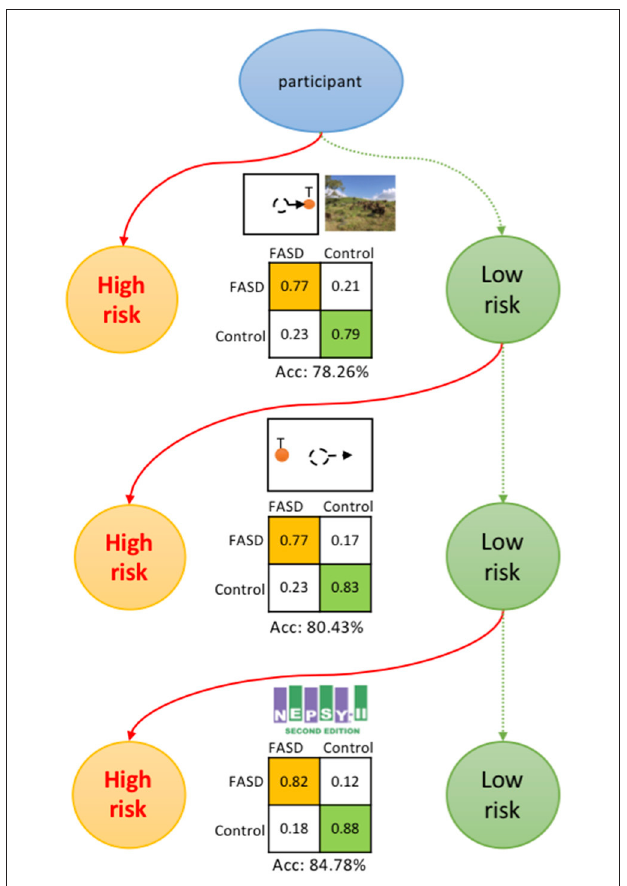
FIGURE 4 | Screening procedure. The participant is first assessed by the ProSac and Natural viewing tasks, with an accuracy of 78.26% for estimating the risk of being FASD. For older children/youth, the addition of the AntiSac task and/or short battery of psychometric tests adds to the classification accuracy, adding greater confidence that at-risk children/youth are not missed. The confusion matrices are also shown.